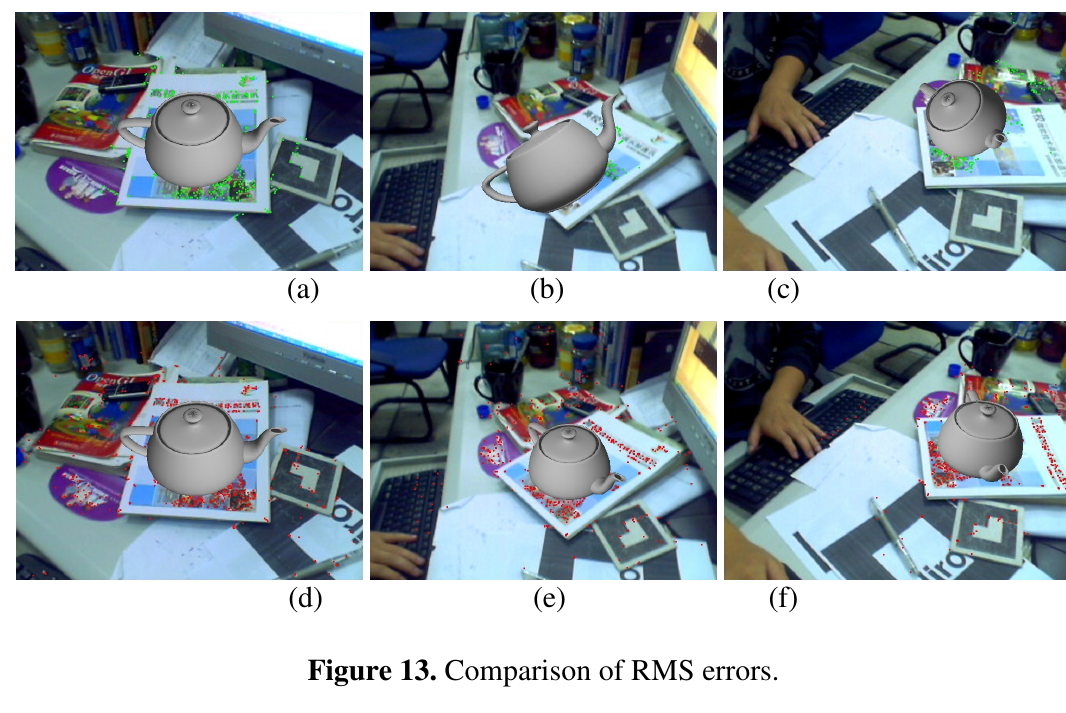
Figure 12. Results of the second experiment used to compare the multiple keyframes based method with two keyframes based method.